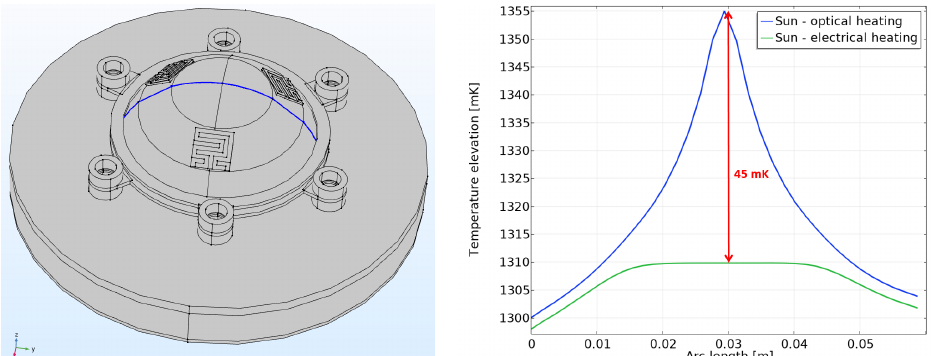
Figure 7. We analyse the temperature elevation along the blue curve that follows the spherical part of the cavity, passing through the top of the cavity ( left ). The graph ( right ) shows the temperature distribution along this curve, for both optical and electrical heating.